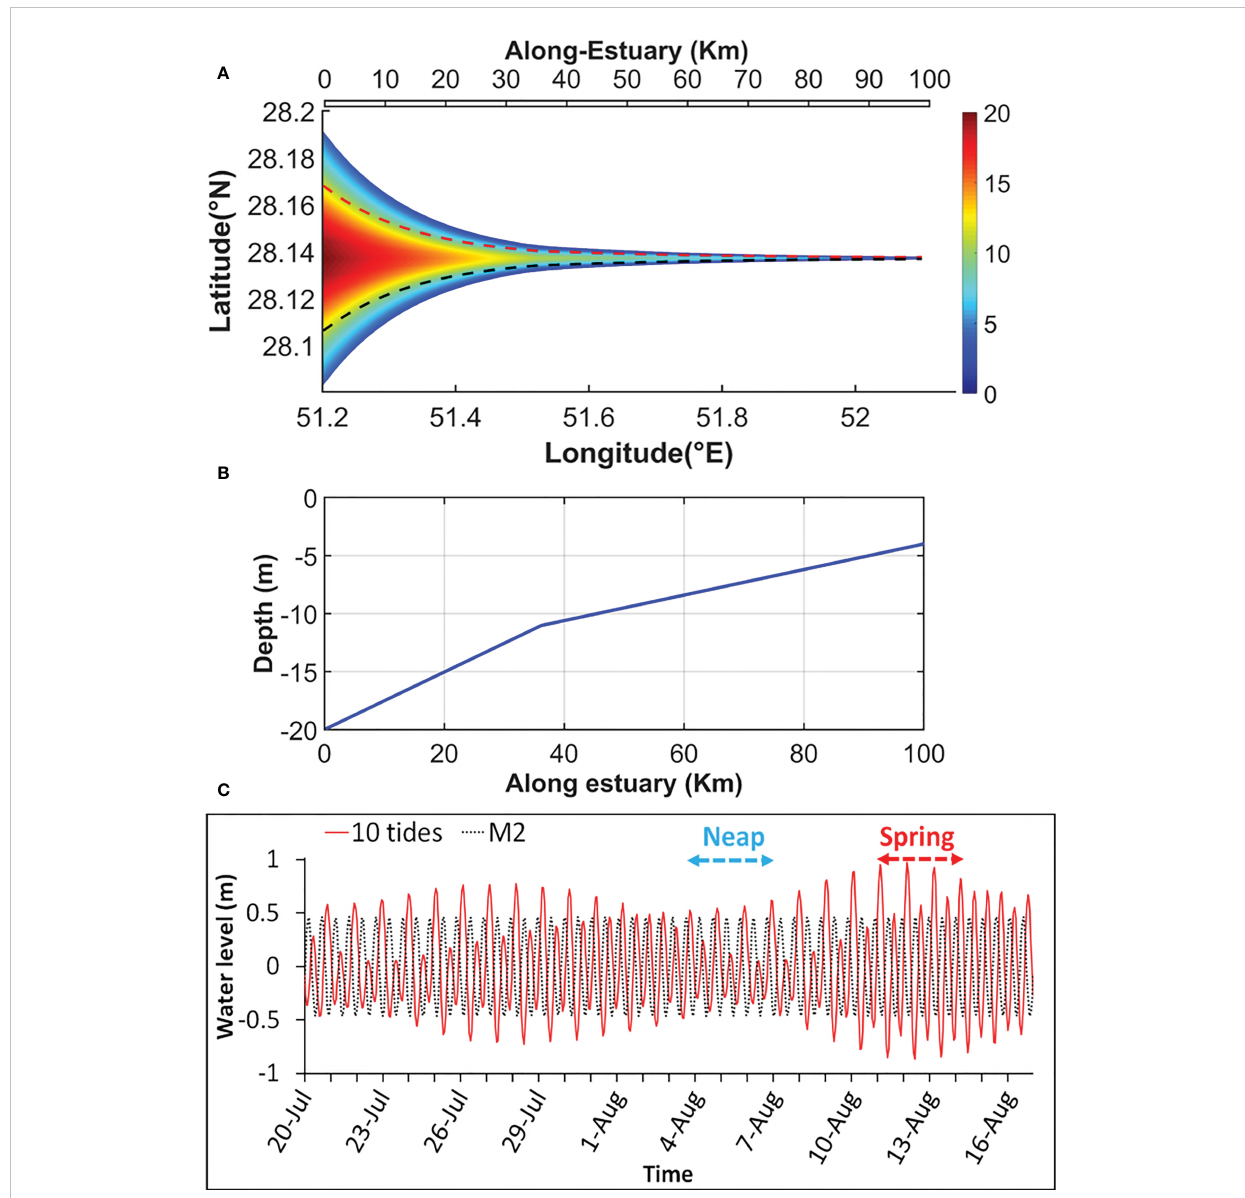
FIGURE 1 (A) The bathymetry (m) of the idealized basin. The red and black dashed lines show the two symmetrical northern and southern transects between the main axis and the northern and southern coasts, respectively. (B) Along-channel depth variation in the idealized estuary used in numerical simulations. (C) Two 28-day time series of water levels depict the open boundary conditions: only M2 tide in EXP1 and EXP6, and 10 tidal constituents in EXP3 and EXP11. Two 75-hour periods during neap and spring tides in EXP3 are shown by the two blue and red double arrows, respectively, during which average model states are